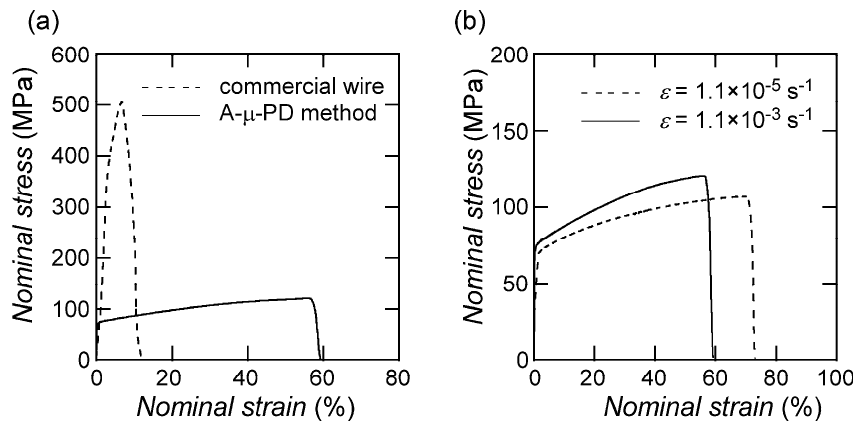
Figure 2. ( a ) Stress–strain curves of Pt fiber A- μ -PD at 10-mm/min growth rate (solid line) and Pt wire WDP (dashed line) at a strain rate of 1.1 × 10 –3 s − 1 . ( b ) Stress–strain curves of Pt fiber A- μ -PD fabricated at 10-mm/min growth rate at strain rates of 1.1 × 10 –3 and 1.1 × 10 –5 s –1 .